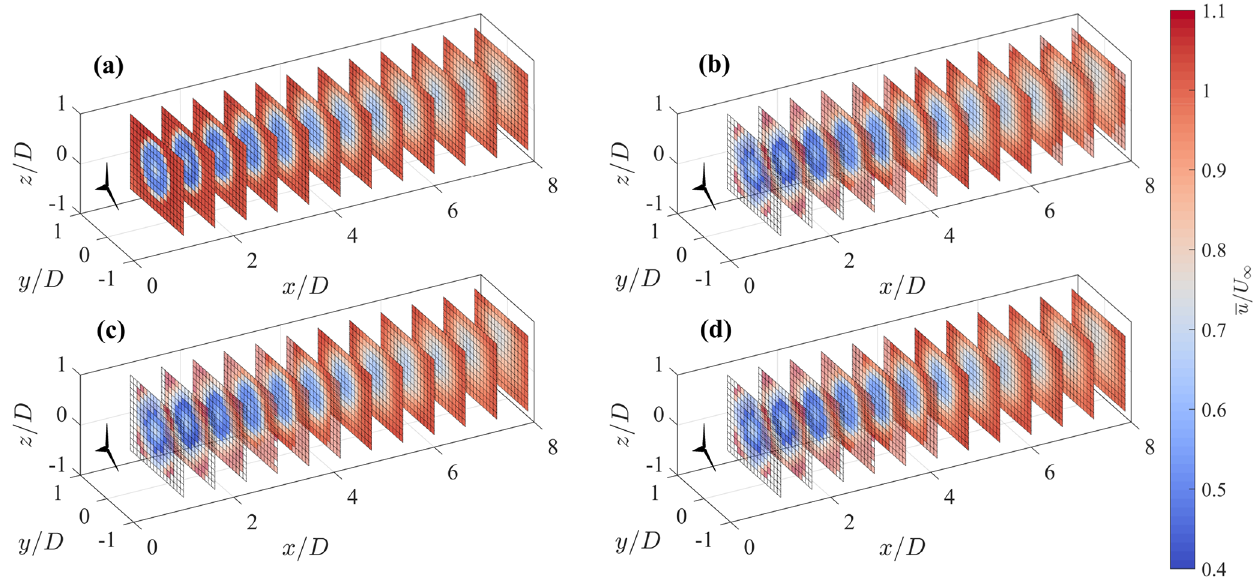
Figure 13. Mean streamwise velocity for (cid:49)θ = 2 . 5 ◦ , σ = 1 / 4, m = 5. (a) LES, (b) ideal lidar, (c) step-stare lidar, and (d) continuous mode lidar. The shaded area corresponds to the points rejected after the application of the Petersen–Middleton constraint.